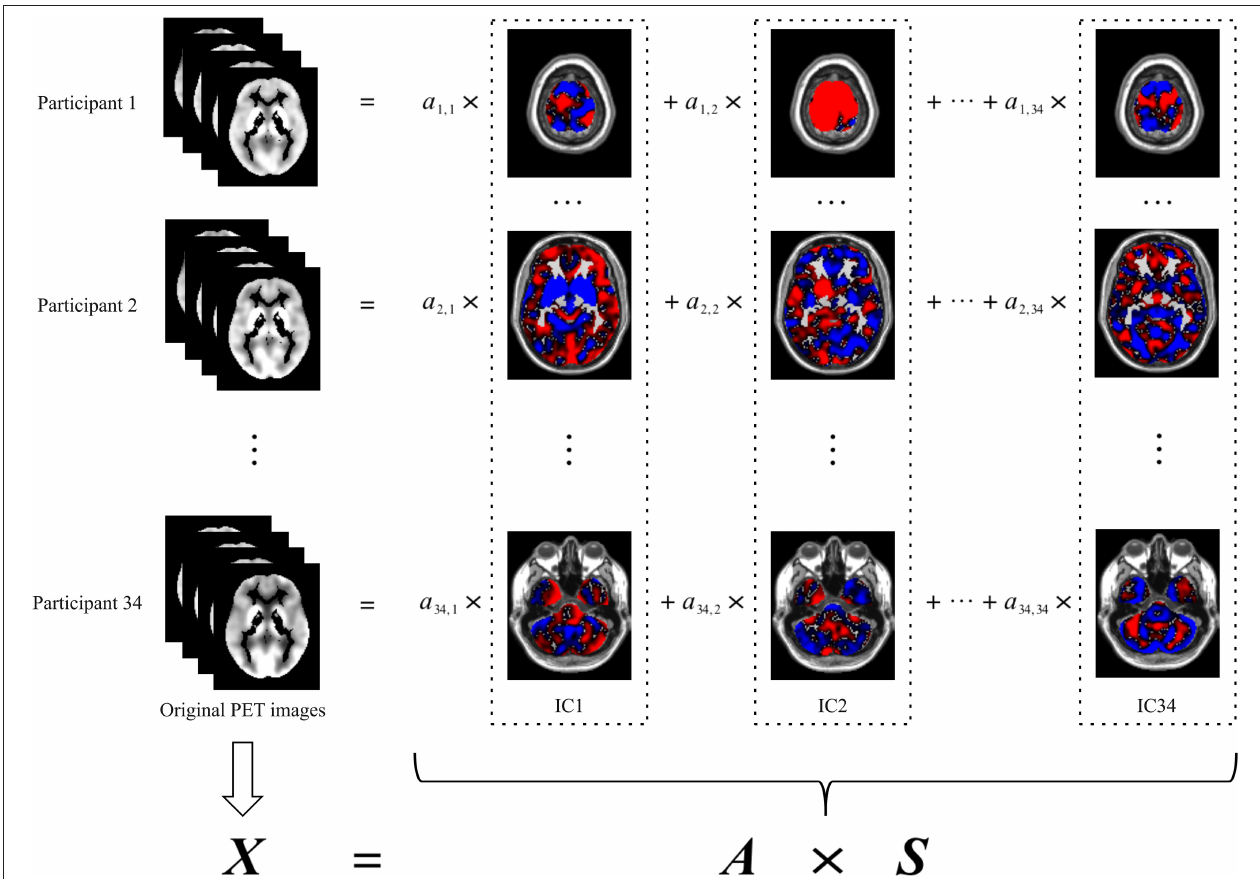
FIGURE 1 | Spatial ICA decomposition of original PET images. The left column indicates the original PET image for each participant. The images in each dash rectangles indicate the corresponding independent component, which is invariant to all participants. The coefficients of each row are specific to the participant of the same row, which is used in the subsequent construction of the classification model in place of the original PET image of the corresponding participant. The coefficients of all participants, namely, a i , j ( i = 1,2,…,34; j = 1,2,…,34), constitute the coefficient matrix (i.e., A ). X denotes the original PET images, each row of which corresponds to an original PET image reshaped into a vector. S denotes the independent components, each row of which corresponds to an independent component reshaped into a vector. ICA, independent component analysis; IC, independent component.